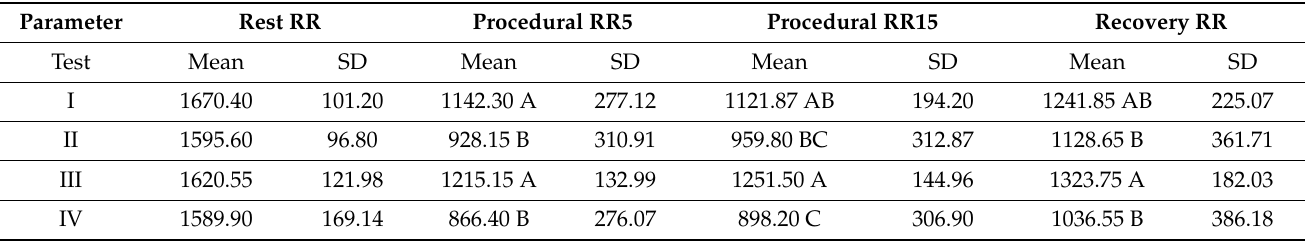
Table 5. RR (RR interval) during consecutive tests.